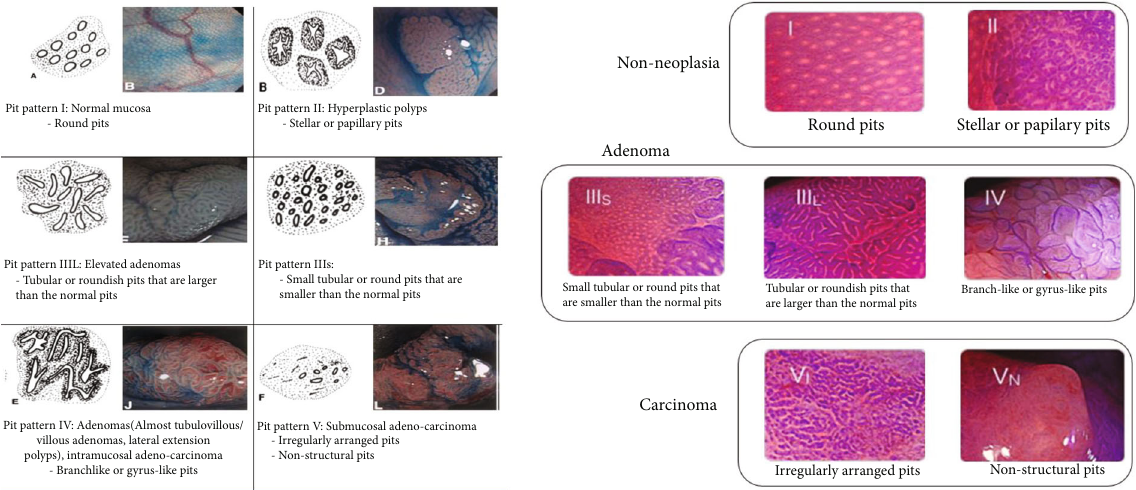
Figure 2: Kudo ’ s pit pattern classi fi cation in magni fi cation endoscopy with Indigo carmine and Crystal violet (Huang et al. [6] and Kobayashi et al.) [7].